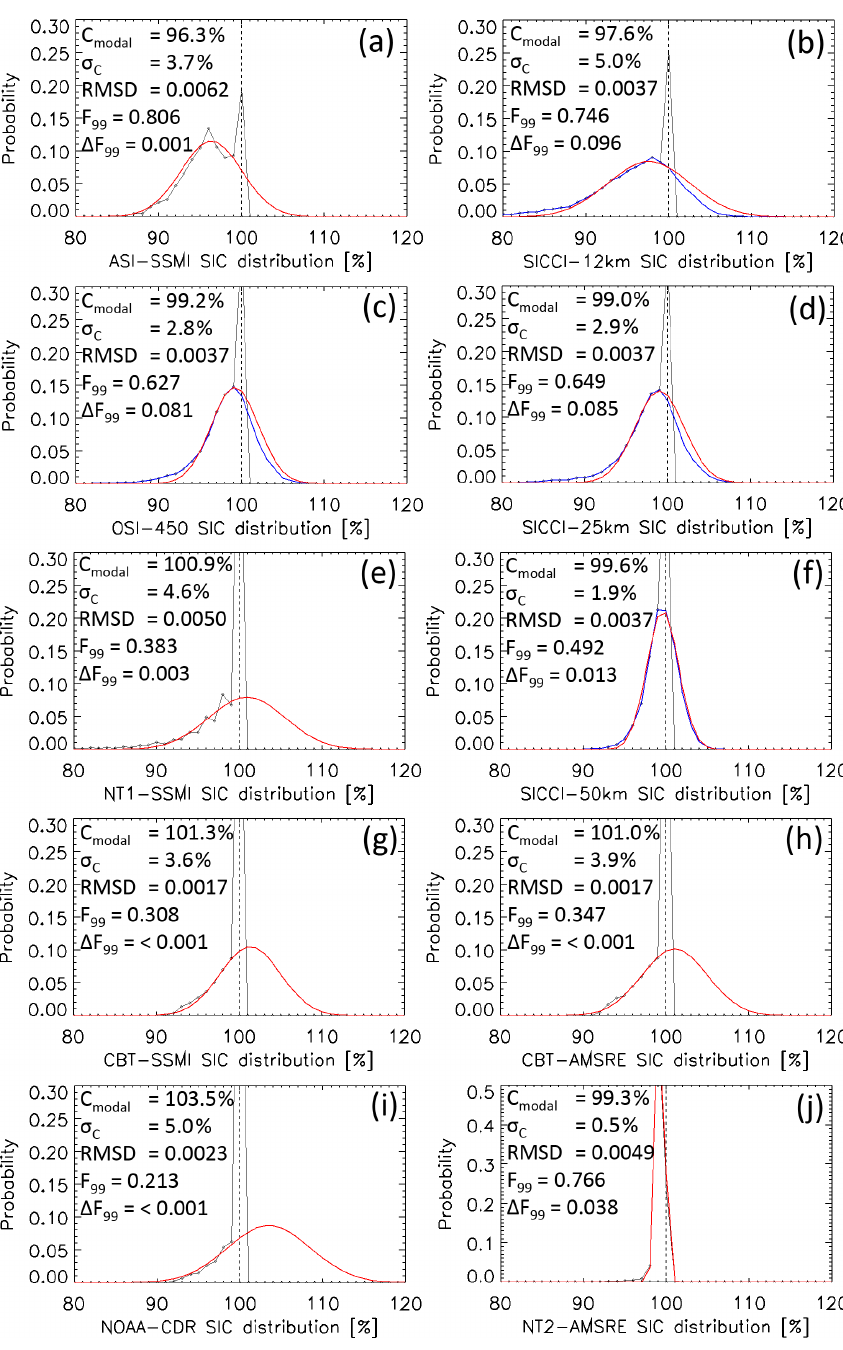
Figure H1. Sea-ice concentration distribution at RRDP2 near-100% reference sea-ice concentration locations in the Arctic during winter for 2007–2011. Black symbols and lines show values cut off at 100%; blue lines denote the original distribution (for OSI-450, SICCI-12km, SICCI-25km, and SICCI-50km); red lines denote the distribution resulting from the Gaussian fit to values of the distribution ≤ 99%. In each image the modal sea-ice concentration (centre of the Gaussian fit: C modal ), the standard deviation of the fit σ C and fit parameters with respect to the fraction of the distribution ≤ 99% ( F 99 , (cid:49)F 99 ; see text in Sect. 2.1.4 for a more detailed explanation), and the root-mean-squared difference (RMSD) between original and fitted probability are